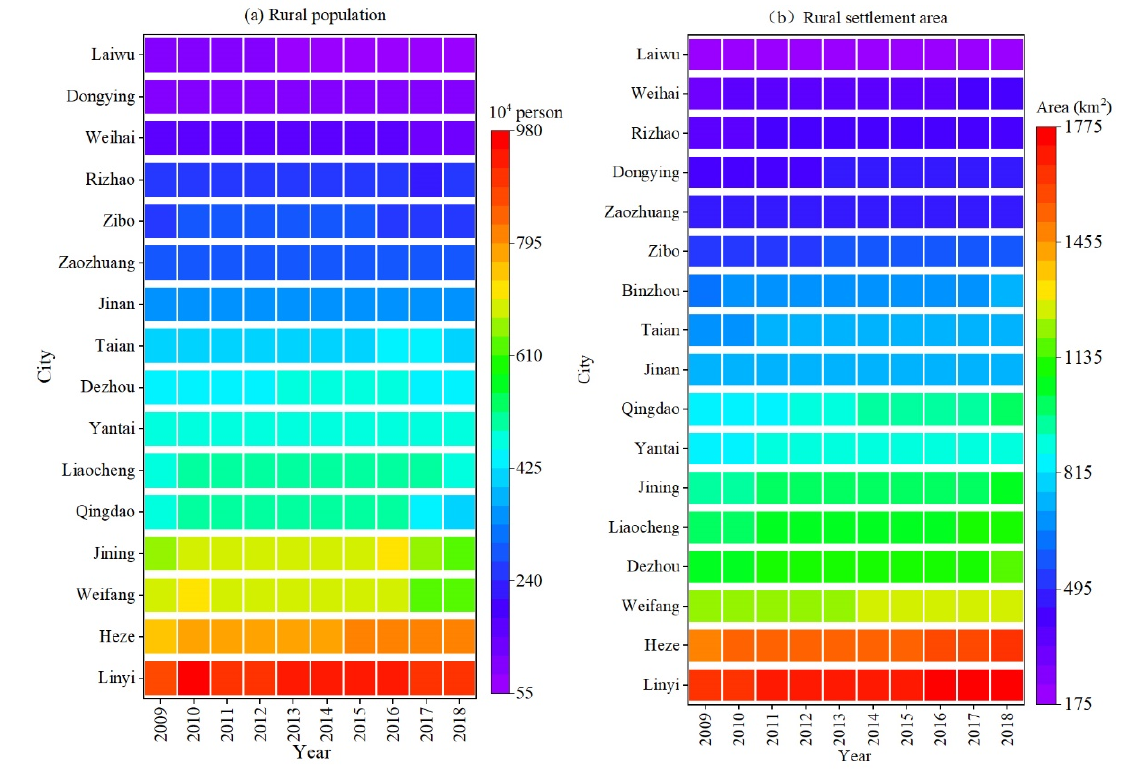
Figure 4. Temporal variation in the rural population size and rural settlement area.